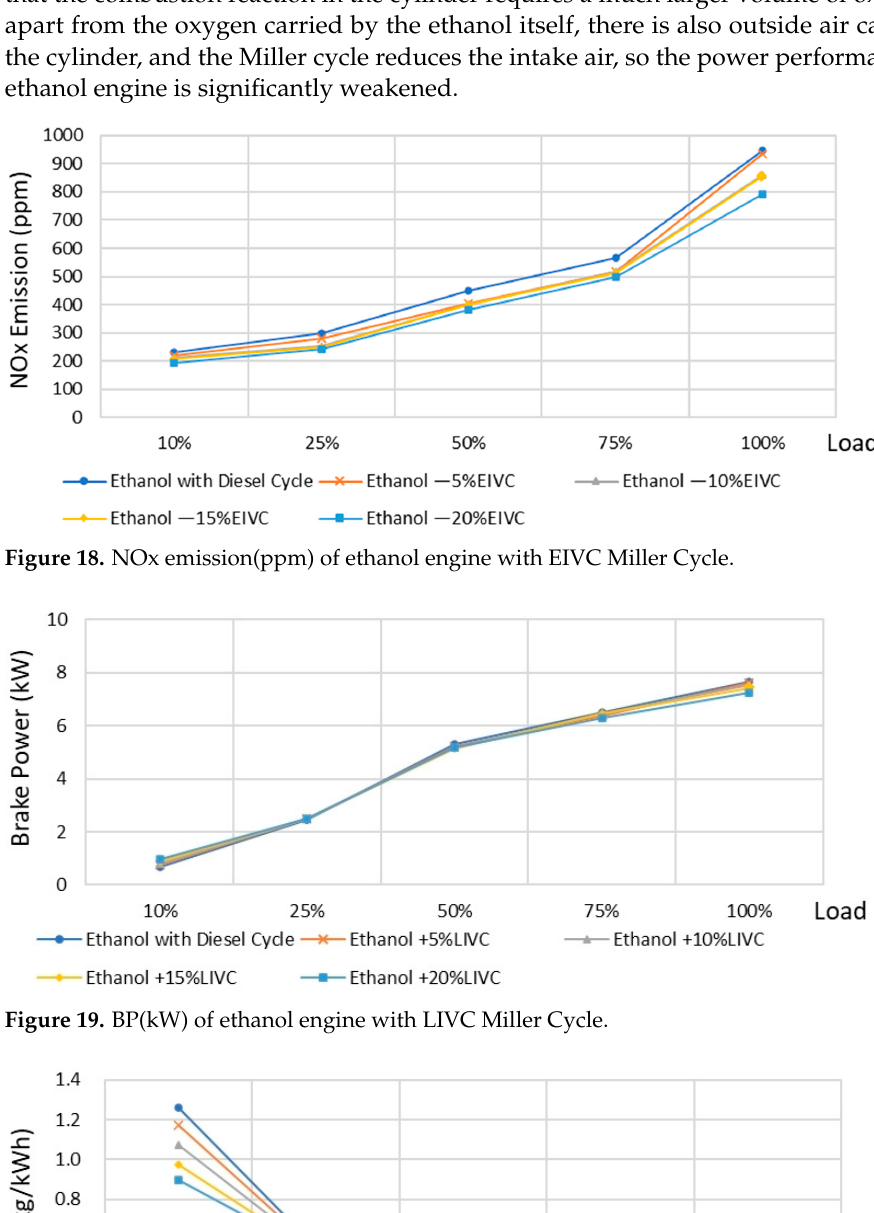
Figure 17. BTEE(%) of ethanol engine with EIVC Miller Cycle.